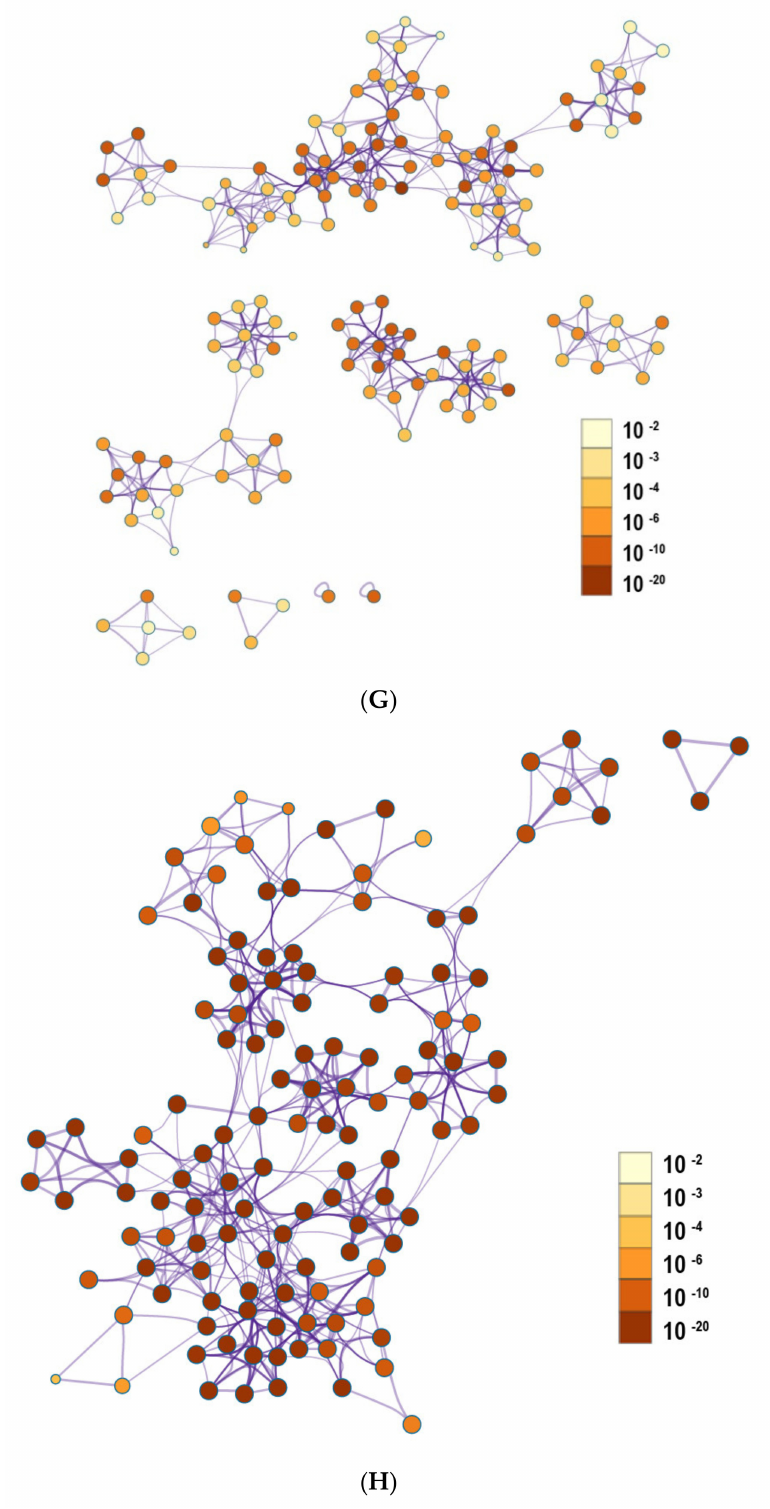
Figure 5. The enrichment analysis results of DEGs by using Metascape. ( A – D ) Bar plot of enriched biological pathways (colored by cluster ID) for down-regulated ( A ) and up-regulated DEGs ( B ) in group 1 (LPS vs. Control) and group 2 (TAK vs. LPS) ( E and G , down-regulated DEGs; F and H , up-regulated DEGs). ( E , F ) The network plot of enriched biological pathways (colored by cluster) for down-regulated ( E ) and up-regulated DEGs ( F ) in group 1 (LPS vs. Control). ( G , H ) Network plot of enriched pathways (colored by p -value) for down-regulated ( G ) and up-regulated DEGs ( H ) in group 1 (LPS vs.